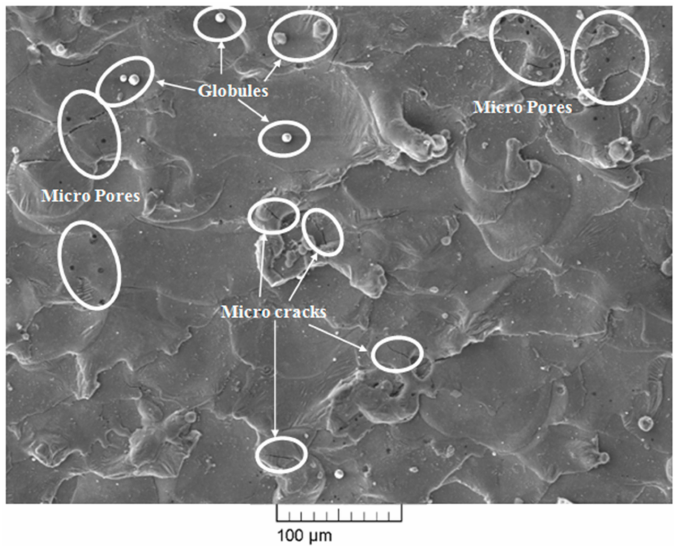
Figure 7. SEM micrograph at low discharge energy level.